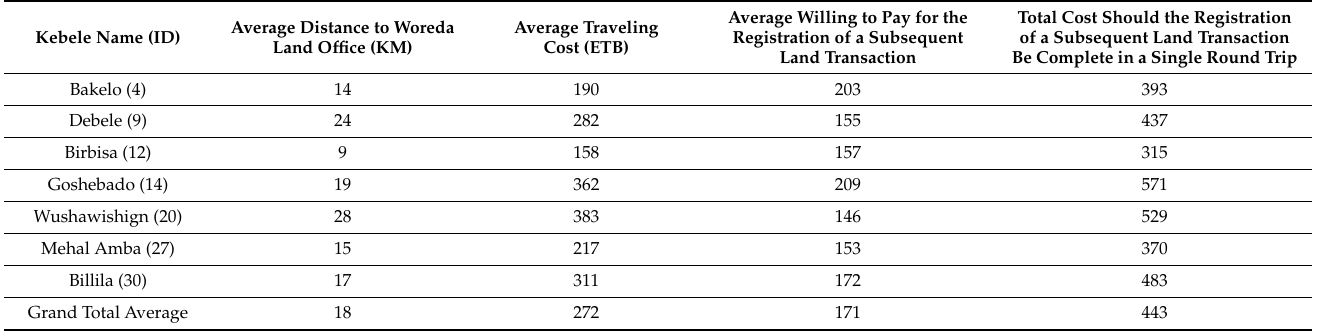
Table 4. Average distance to woreda land administration office, cost of travel/round trip, and willingness to pay for the registration of a subsequent land transaction. Source: Authors’ compilation from household